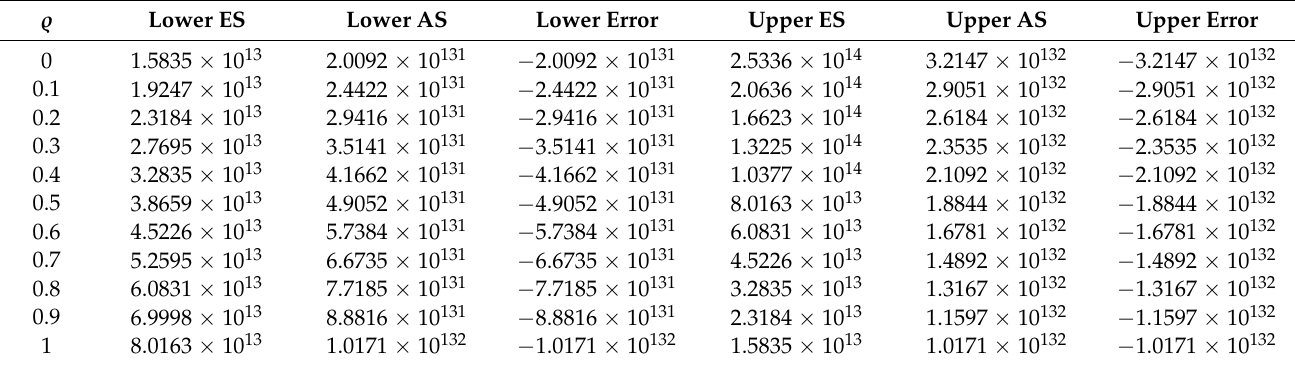
Table 3. Table for the error term between exact solutions (ES) and approximate solutions (AS).